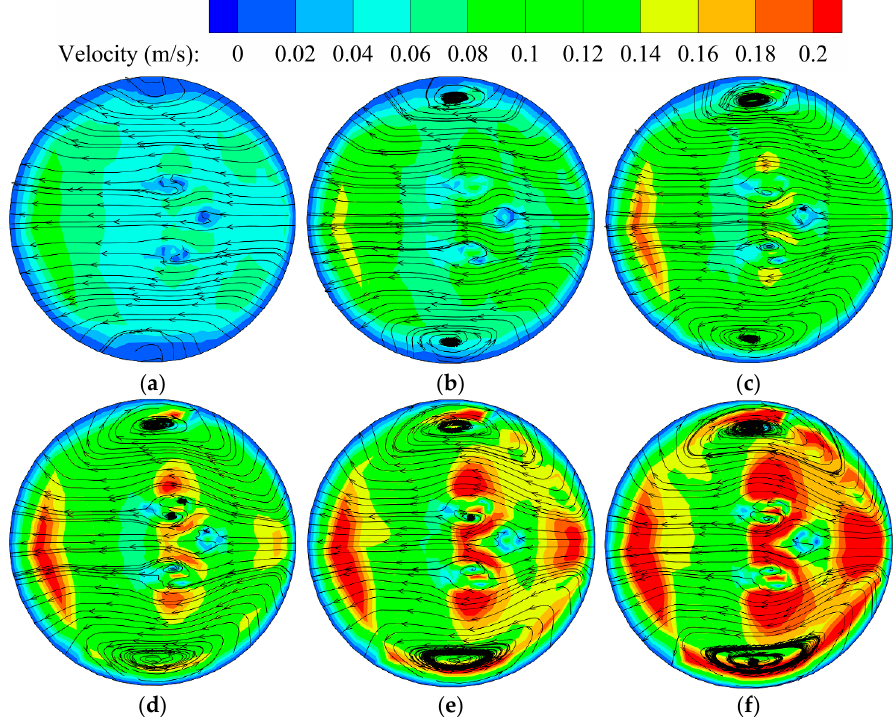
Figure 9. Cross-section A3 velocity and streamline distribution. ( a ) 0.33 Q d , ( b ) 0.67 Q d , ( c ) 1.00 Q d , ( d ) 1.33 Q d , ( e ) 1.67 Q d , and ( f ) 2.00 Q d . ( d ) 1.33 Q d , ( e ) 1.67 Q d , and ( f ) 2.00 Q d